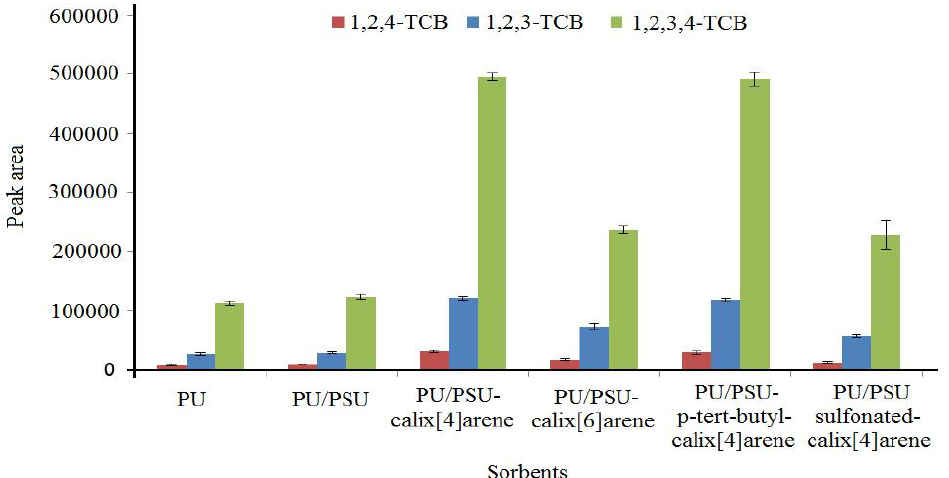
Figure 2. The extraction efficiency of different fabricated nanofibers.